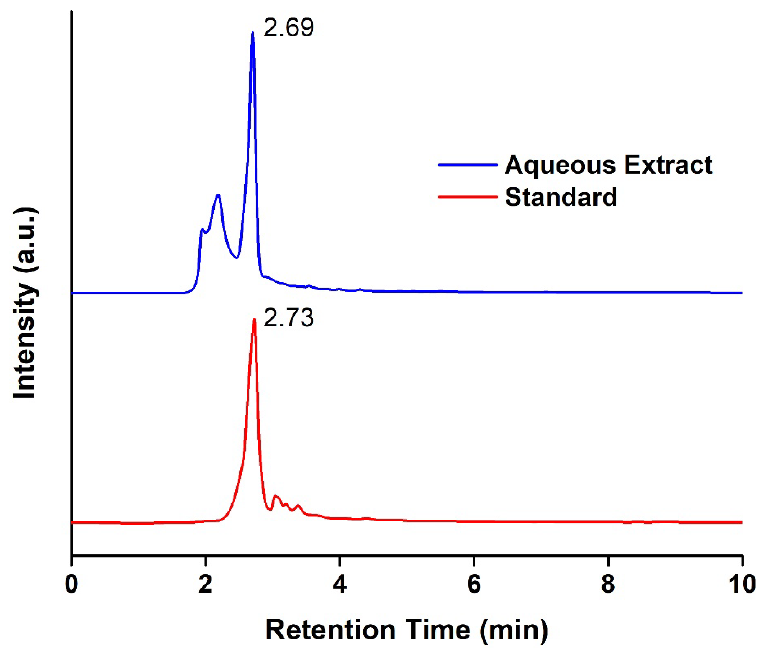
Figure 3. HPLC chromatograms of standard gallic acid and Cascabela thevetia aqueous leaf extract